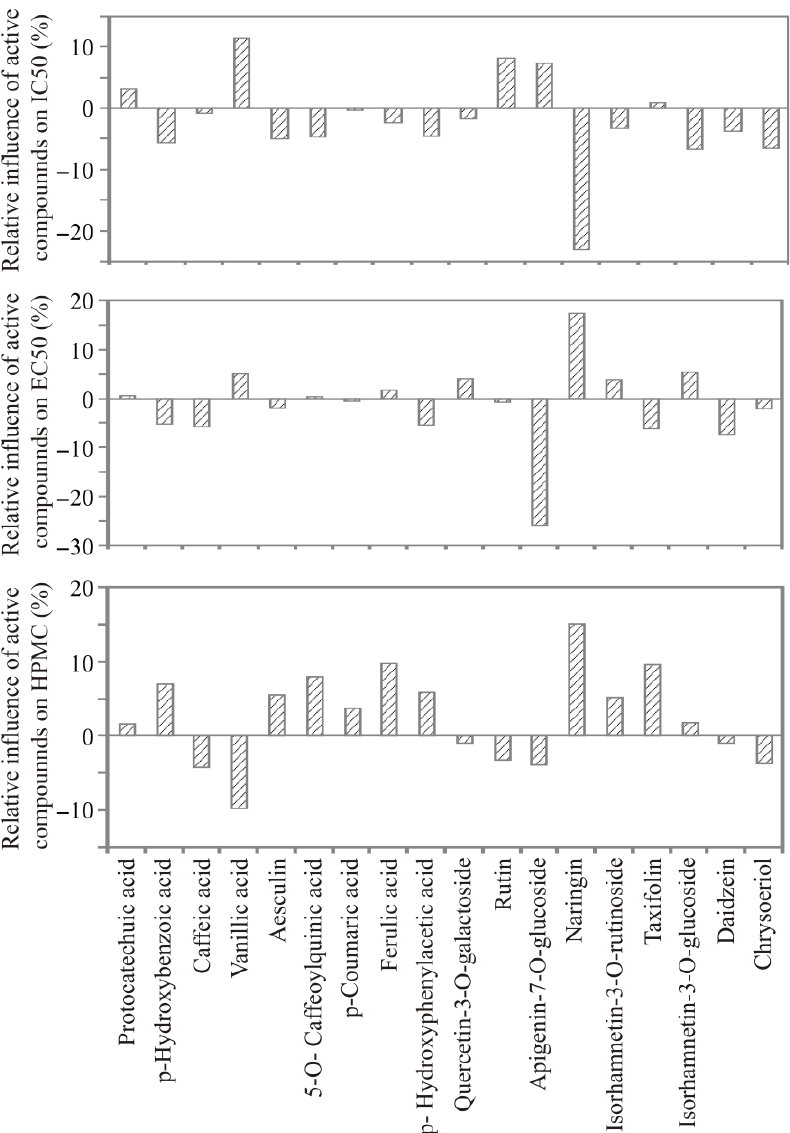
Figure 2. The relative importance of the polyphenols content on antioxidant activity assays of extract obtained from exhausted leaves.